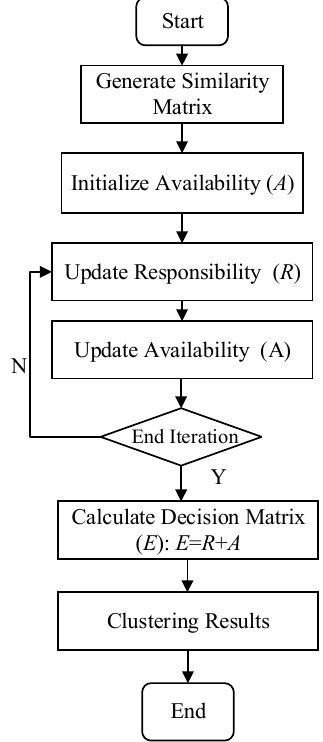
Figure 3. Flowchart of affinity propagation clustering.